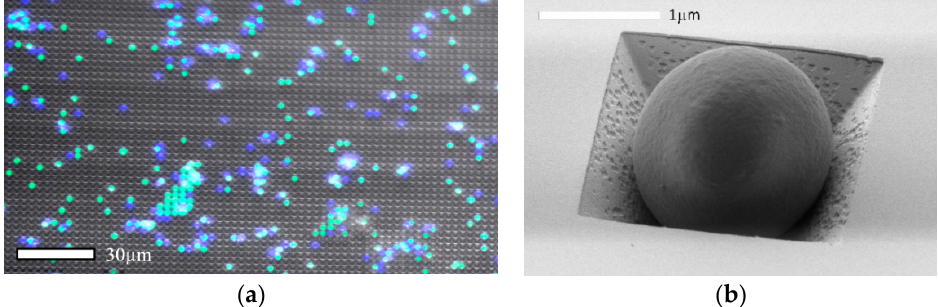
Figure 6. Fluorescent beads with approximately 2 µ m diameter (SA—green and ST—blue) entrapped in the periodic array of perforated pyramidal structures: multichannel fluorescent image ( a ) and SEM image ( b ).